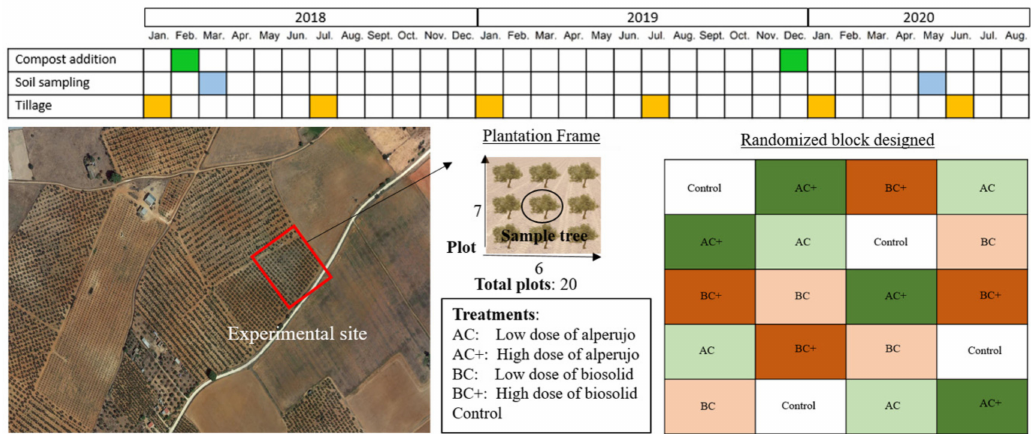
Figure 1. Description of the experimental design of the olive trees orchard and treatments